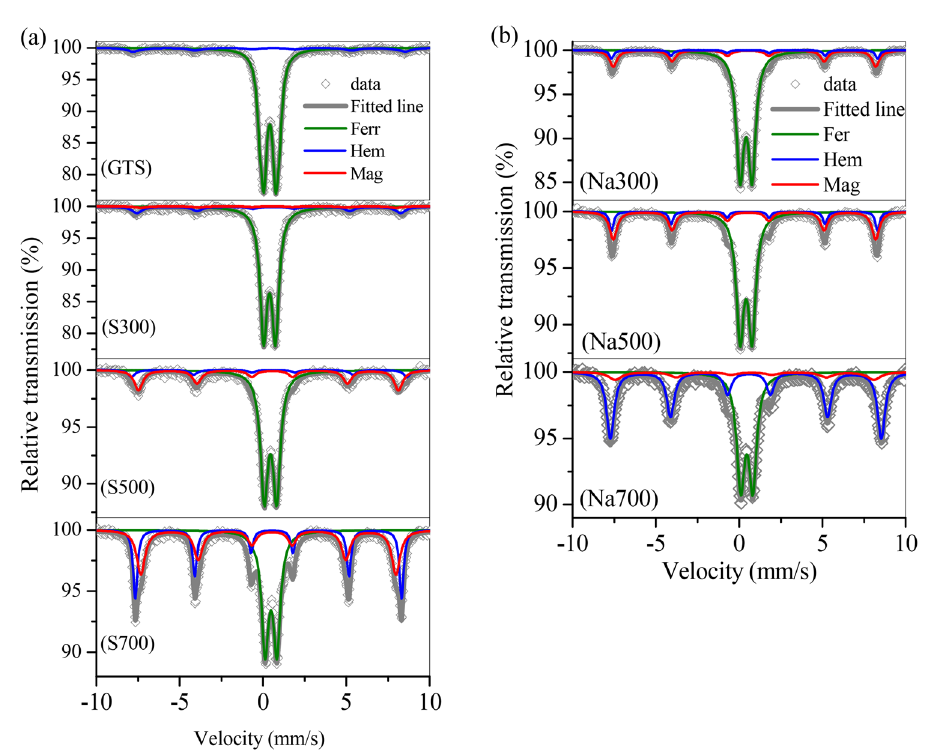
Figure 3. Mössbauer spectra of ( a ) GTS, S300, S500, S700, and (b) Na300, Na500 and